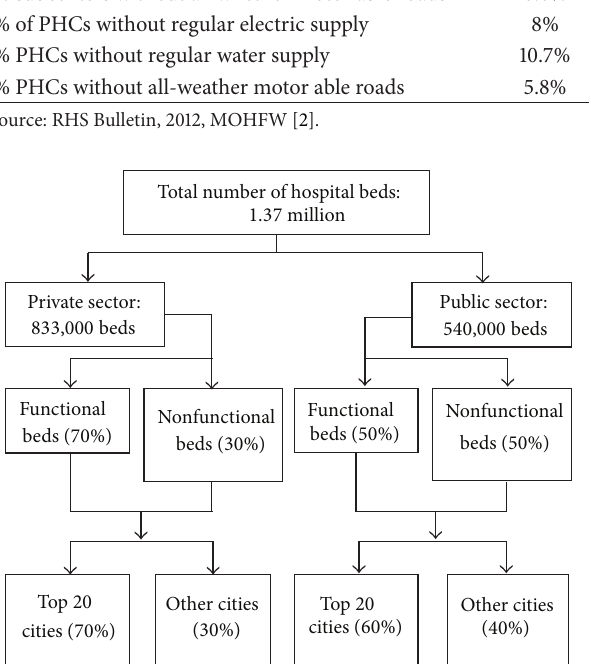
Figure 1: Distribution of available hospital beds in India. Source: